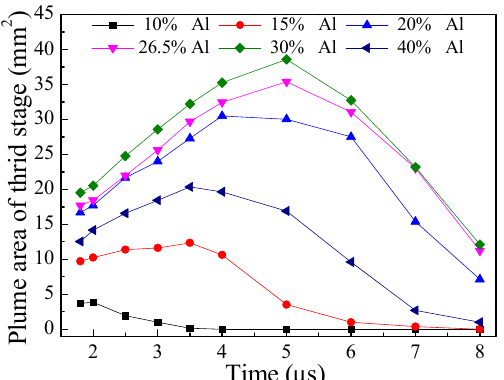
Figure 12. The plume area of third stage variation with time at different proportions of Al (ambient pressure 0.005 Pa and laser energy 542.3 mJ).